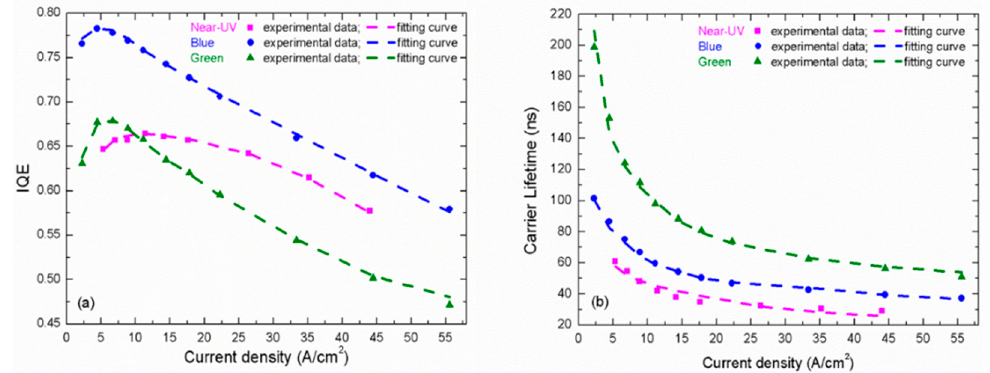
Figure 5. ( a ) IQE; and ( b ) carrier lifetimes depending on injection current density. Dot: experimental data; dash line: fitting curve.